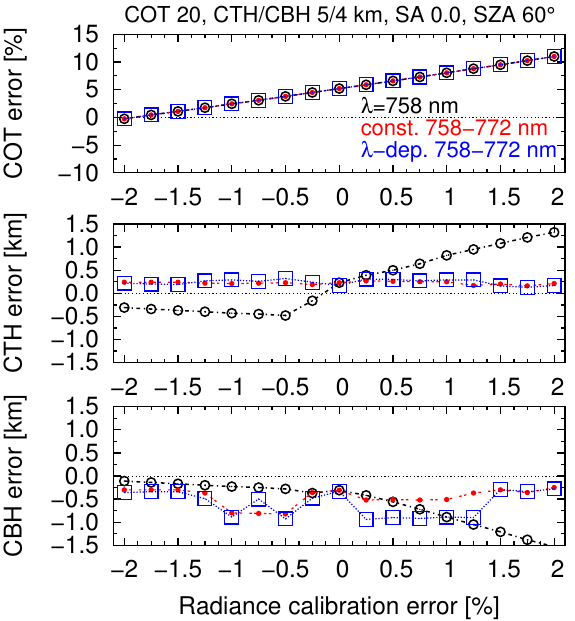
Figure 15. Errors in retrieved cloud optical thickness (%, top plot), cloud top and bottom height (km, middle and bottom plot) for a single-layered cloud, placed at 5–4km altitude and optically dense 20, above a dark surface. Three different offsets in radiance are ap- plied: single-channel at λ = 758nm (black curves); constant, added along the whole band (red curves); linearly spectral-dependent, as described in Noël (2005) (blue